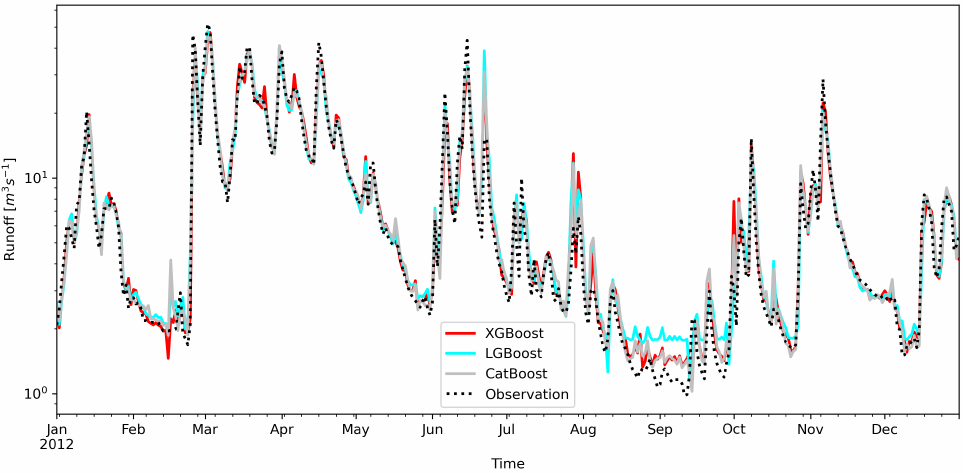
Figure 8. Daily runoff forecast for Wadowice on Skawa River in year 2012—low flows case. High flows are usually underestimated by all models. With the XGBoost model, the greatest deviations from the observations can be noticed. The tested models have similar unknown reasons, the flow predicted by XGBoost is overestimated here for high flows and underestimated for low flows. The middle of August 2017 is particularly interesting, where the XGBoost forecast is very different from the other